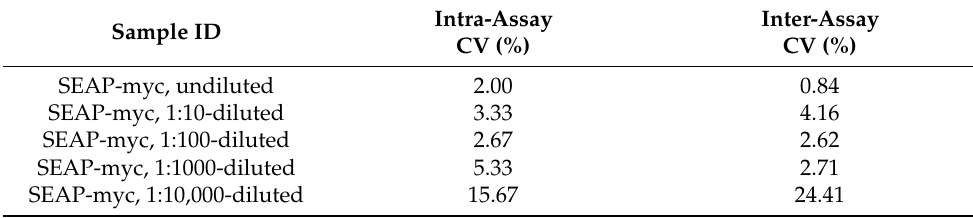
Figure 1. Characterization of chemiluminescent secreted alkaline phosphatase (SEAP) assay. ( a – c ) SEAP enzymatic activity ( a ), assay linearity ( b ), and assay sensitivity ( c ) were determined in undiluted and up to 10,000-fold diluted cellular supernatants of HEK293T reporter cells, 24 h after cell seeding (mean ± SD, n = 3). Negative control is represented by the cell culture supernatant from empty vector-expressing HEK293T cells. RLU: relative luminescence units. Table 1. SEAP assay variability.